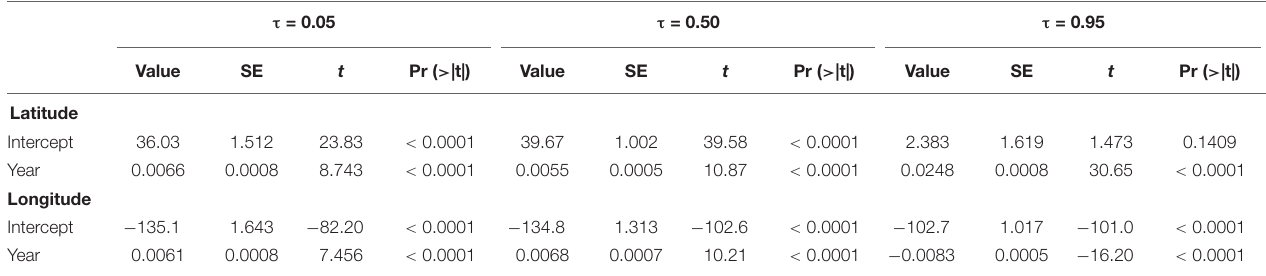
The location of infestations was determined by ground observations from 1909 to 1960 and from aerial surveys thereafter. Regressions were fit to the 5th ( τ = 0.05), median ( τ = 0.50) and 95th ( τ = 0.95) quantiles. Data were provided by the BC Ministry of Forests, Lands, Natural Resource Operations and Rural